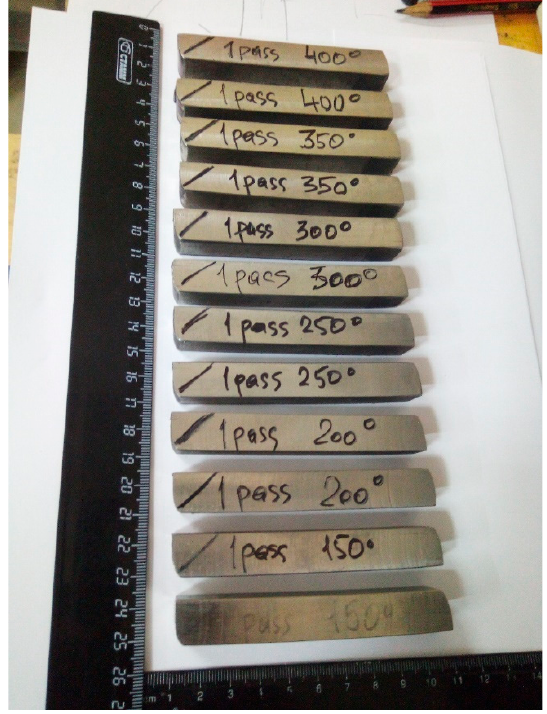
Figure A2. The steel AISI 321L workpieces after ECAP at different temperatures.